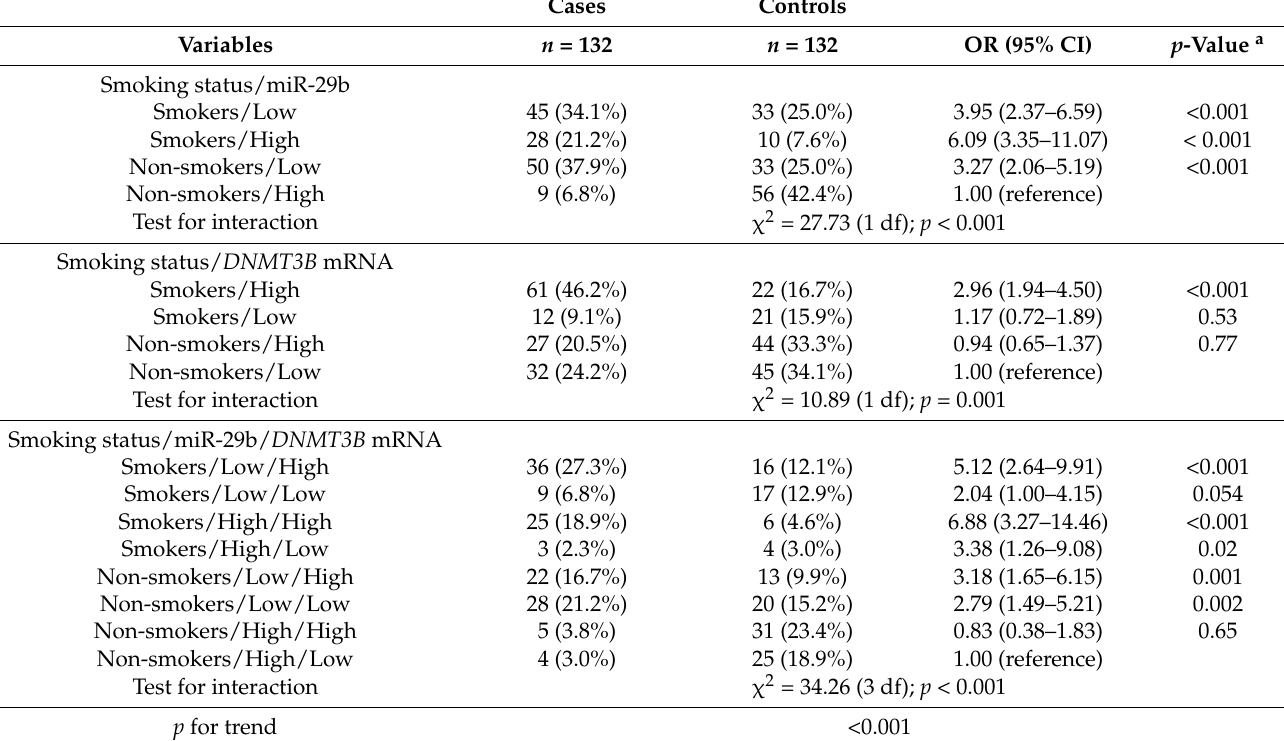
Table 4. Joint effects of smoking status with miR-29b and DNMT3B mRNA in lung cancer develop- ment.